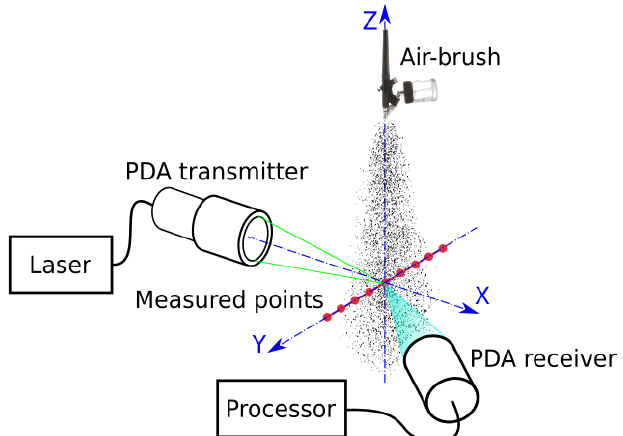
Fig. 2 . Measurement volume